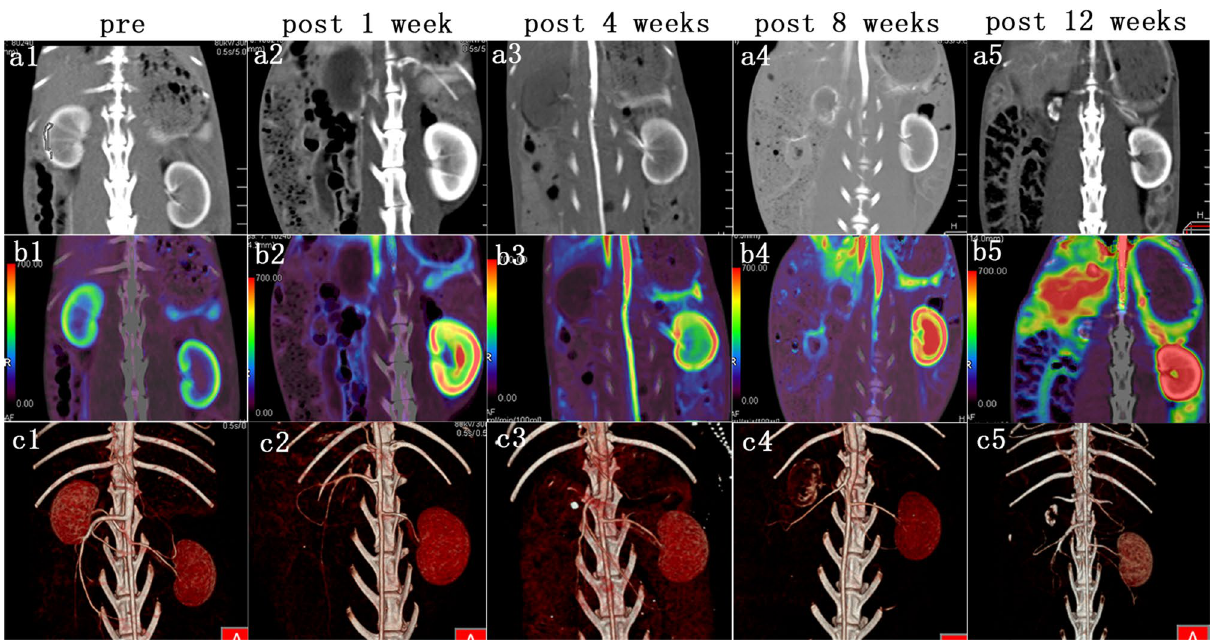
Figure 4. Images of CT examinations before and after embolization at various times. ( a1-5 ) Enhanced images show significant shrinkage of the right kidney, with large calcifications. ( b1-5 ) The perfusion maps show different colors of BF in the right kidney. ( c1-5 ) The VRT images show significant calcification of the right kidney, but the left kidney and large blood vessels are clearly